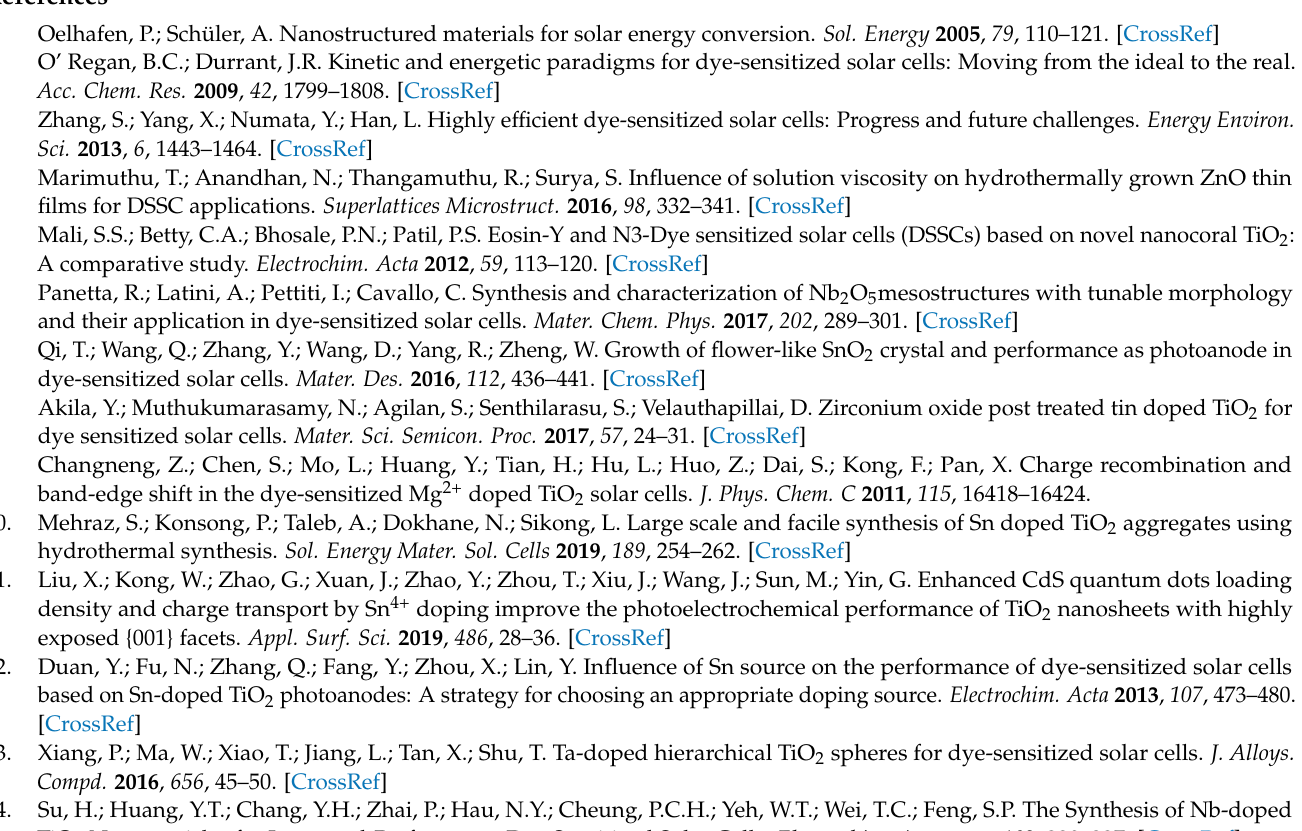
like morphology; Figure S4: XPS survey spectrum of 7-wt % Sn-TiO2; Figure S5: Morphological variation from nanorods to nano-flower; Table S1: Crystal structure parameters of bare-TiO 2 and Sn-TiO 2 thin